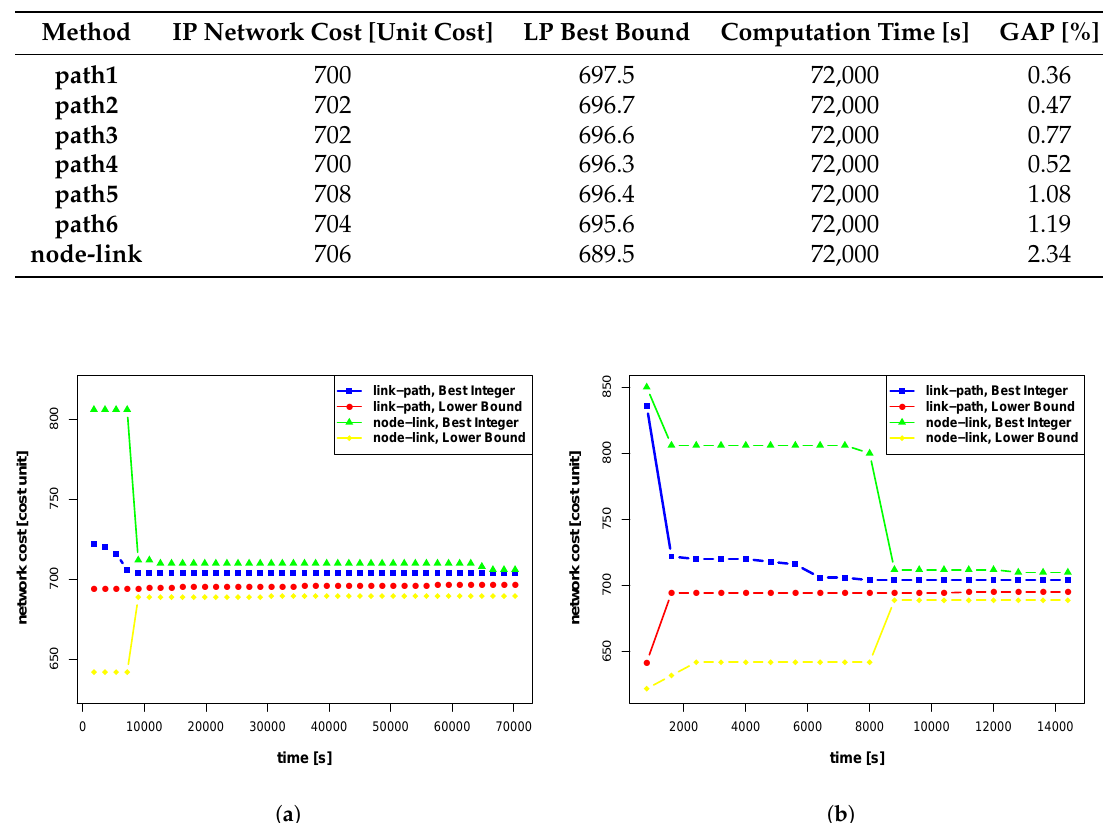
Table 5. Comparison for Polish network using CDC-ROADM node model of link-path approach (path#) and node-link approach (node-link), while d = 70 Gbps , s = 32, and p = 1.